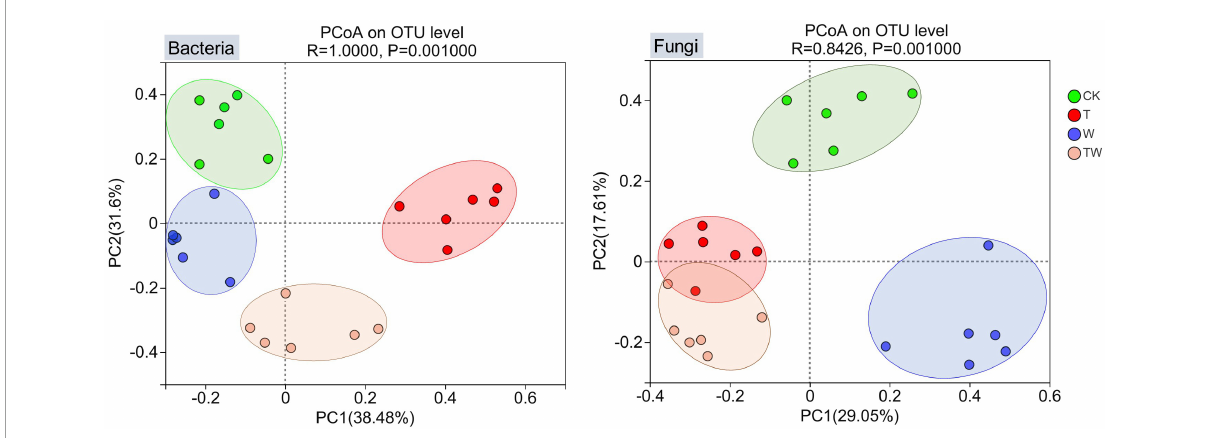
FIGURE3 Principal coordinates analysis (PCoA) of soil bacterial and fungal communities. The values associated with axes 1 and axes 2 are the percentage contribution that can be explained by the corresponding axis. CK, control; T, increasing temperature; W, increasing precipitation; TW, their interaction.